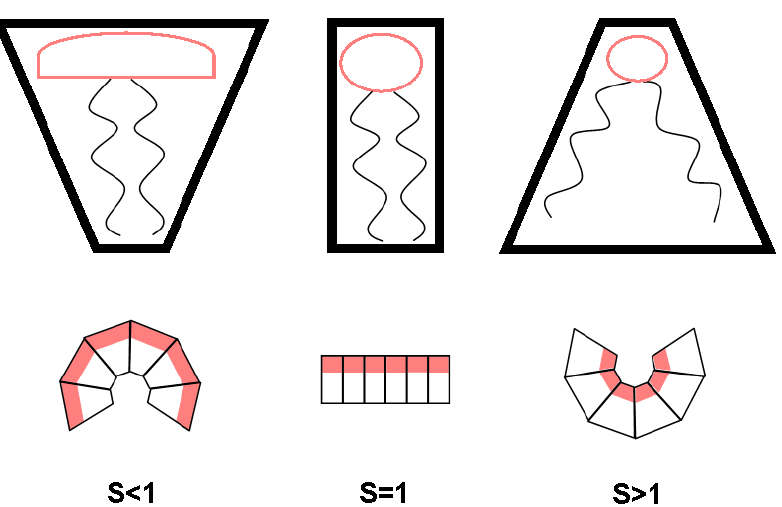
Figure 3. Cartoon illustration of differently-shaped lipids and the associated